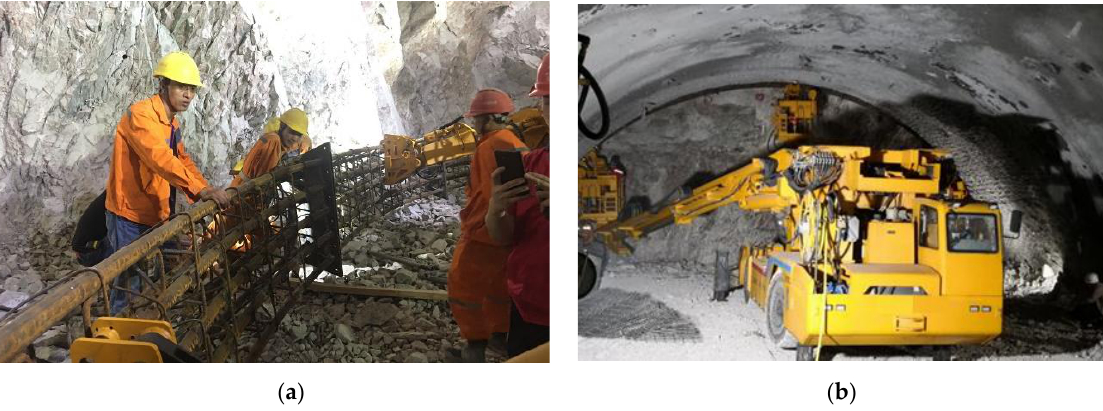
Figure 25. Mechanized installation of the arches. ( a ) Assembled arches near the ground and ( b ) the installation of upper bench arches.